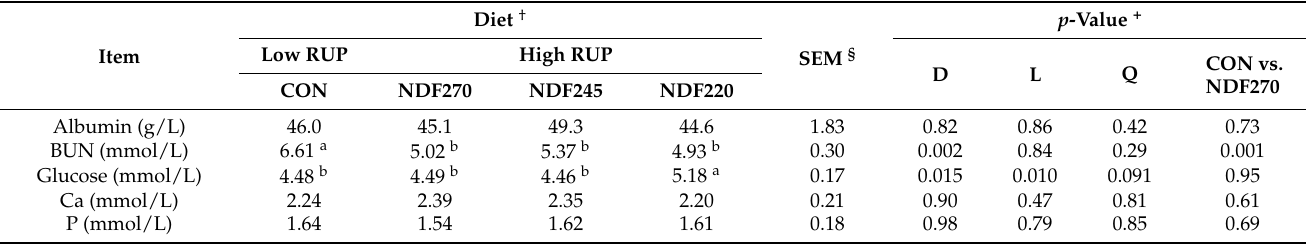
Table 5. Effects of feeding different levels of neutral detergent fiber (NDF) and rumen undegradable protein (RUP) on blood plasma attributes of finishing lambs.